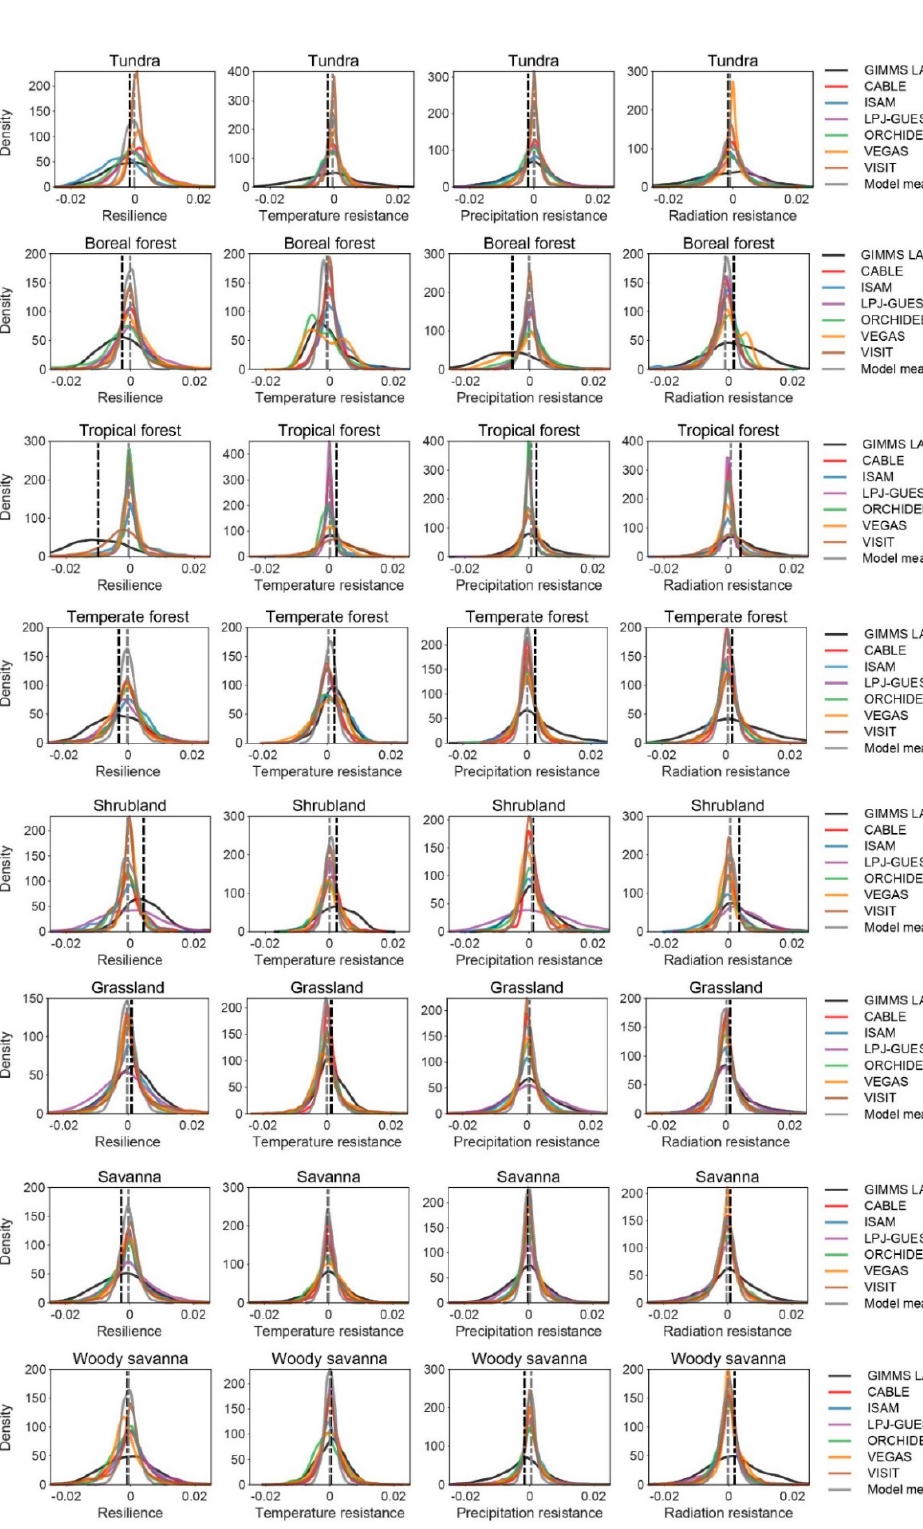
Figure 8. Probability distributions of the changes in vegetation resilience and resistance derived from observations and models at the biome scale. The eight biomes include tundra, boreal forest, tropical forest, temperate forest, shrubland, grassland, savanna, and woody savanna. The gray dashed line represents the mean vegetation resilience and resistance of the GIMMS LAI. The black dashed line represents the mean vegetation resilience and resistance changes of the model mean. The distribution curves are fitted with kernel smoothing function estimates for vegetation resilience and resistance changes.